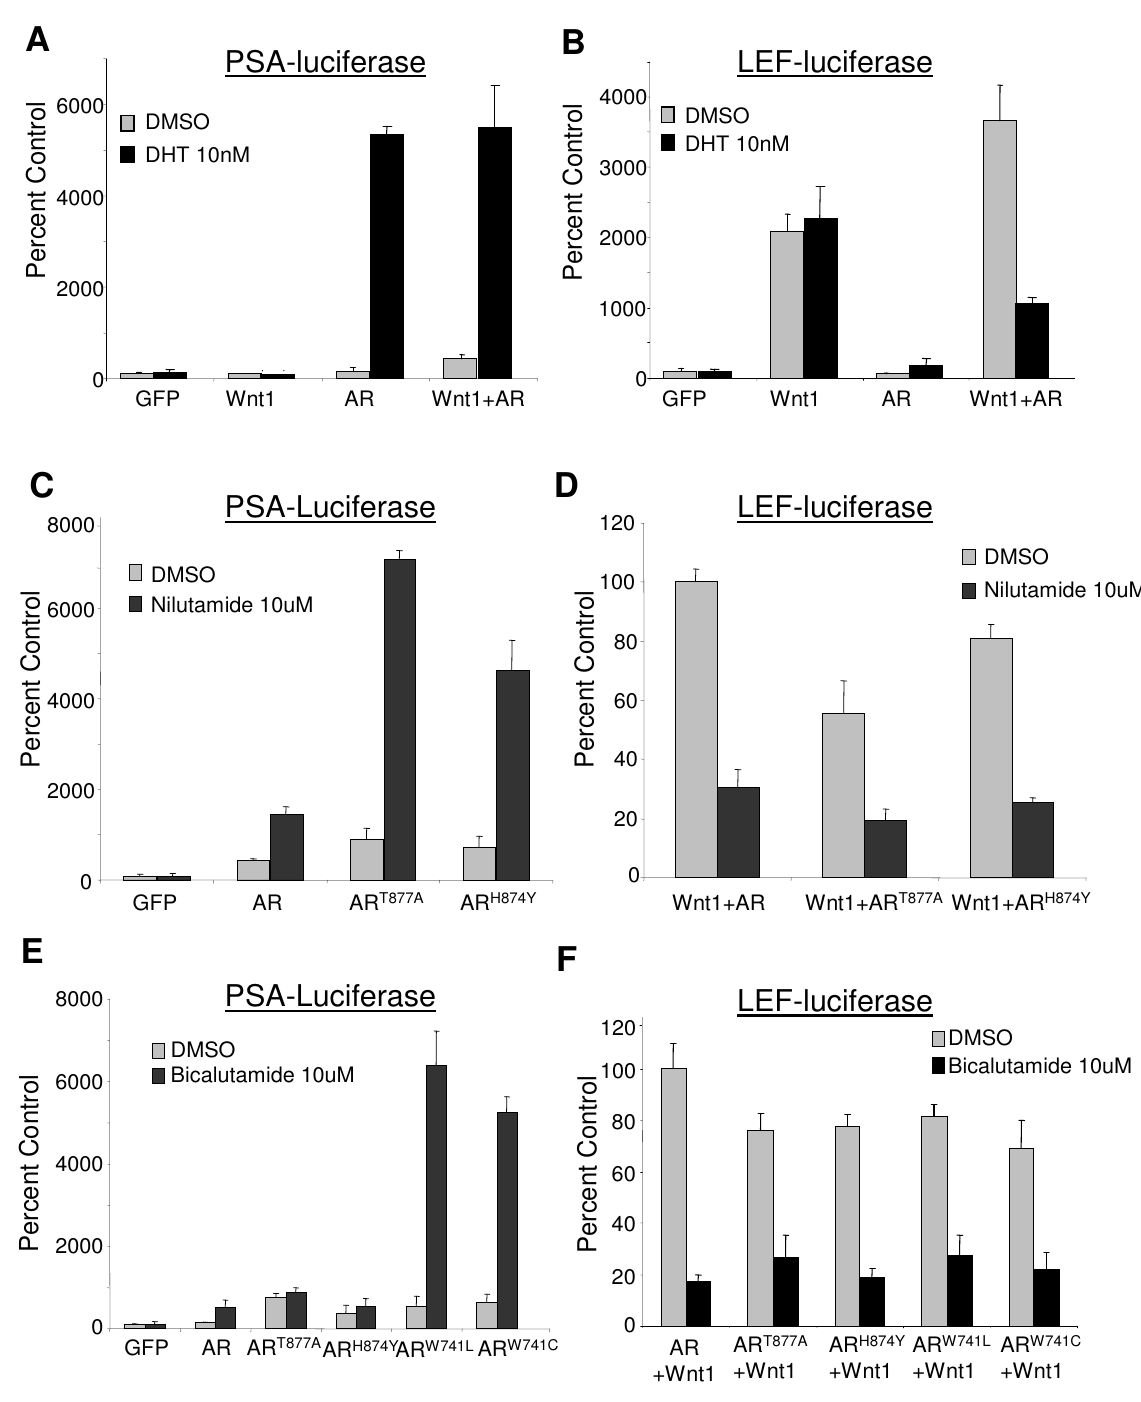
Figure 3 AR agonists inhibit the Wnt and AR synergy . PC3 cells in phenol-red free RPMI with 5% charcoal-stripped serum in 96 well plates were transfected with the indicated plasmids, together with pCMV-Renilla reporter and PSA-luciferase (A, C, & E) or LEF-Luciferase (B, D, & F). The following treatments were applied to cells 4 hours after transfection: 10 nM DHT (A & B); 10 uM Nilutamide (C & D); 10 uM Bicalutamide (E & F). Dual luciferase assays were performed 20–24 hours after